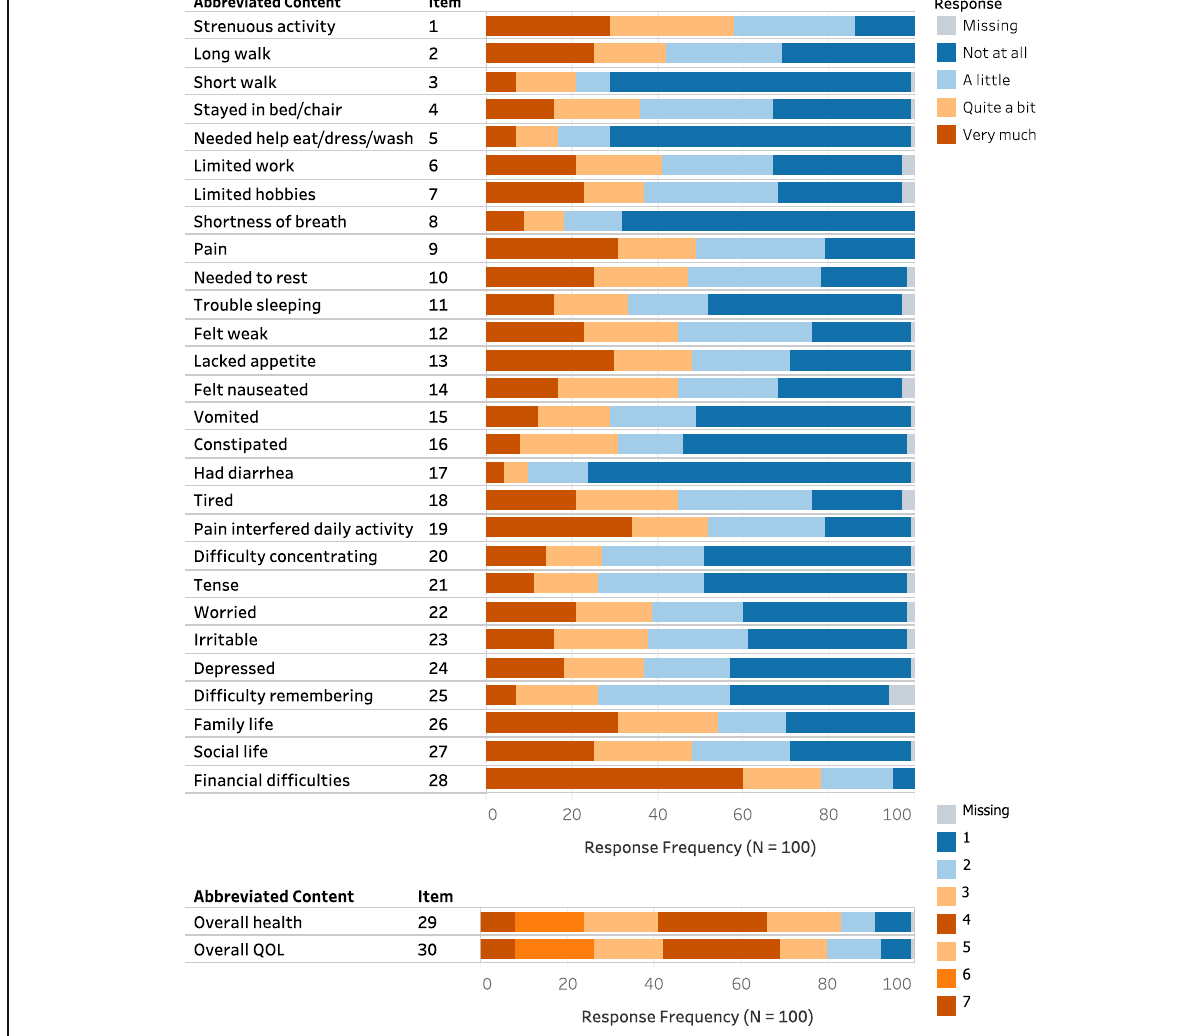
Fig. 1 Percentage of missing values and frequency distribution of responses to the EORTC QLQ-C30. Items 1 – 28 have 4 response categories namely, “ Not at all ” , “ A little ” , “ Quite a bit ” , and “ Very much ” . Items 29 – 30, which are related to global health status and overall QOL, have response options between 1 and 7, where 1 is “ Very poor ” and 7 is “ Excellent